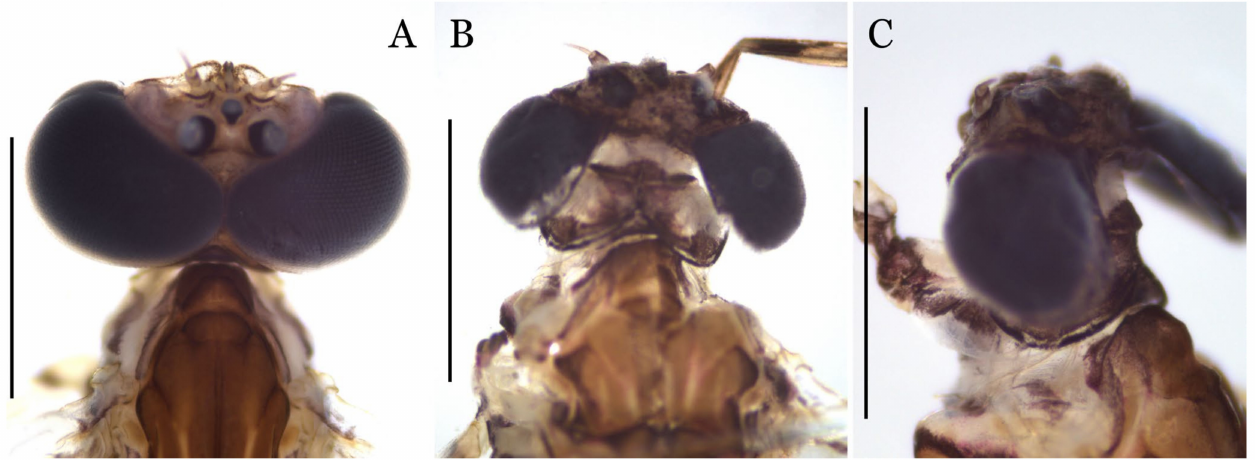
Figure 6. Imaginal head of Maculogenia ngi (digital photos): ( A ) male imaginal head (dorsal view); ( B ) female imaginal head (dorsal view); ( C ) female imaginal head (lateral view). Scale bars: ( A – C ) = 1.0